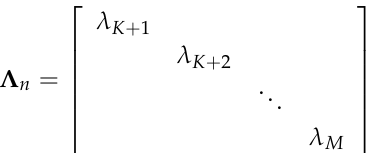
1. Solve the anti-jamming weight vector w according to spatial filtering algorithm; 2. Calculate the spatial spectral function F ( φ ) about the anti-jamming vector and determine the direction angle φ corresponding to the null, and the steering vector A of the interference signal can be